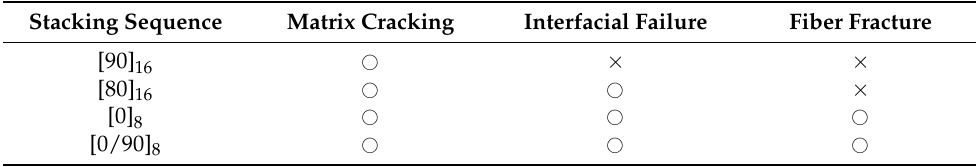
Table 1. Stacking sequence of fiber-reinforced plastics and dominant fracture modes [20].